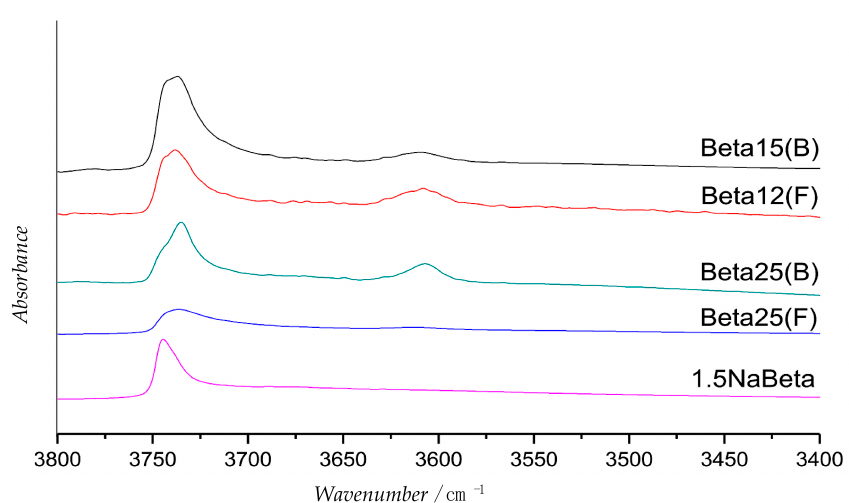
Figure 8. IR spectra of Beta-zeolites synthetized in fluoride (F) and OH − media (B). The silanol band at 3745 cm − 1 is less pronounced for Beta-zeolites prepared in a fluoride medium and for Beta-zeolite with higher Si / Al ratio. Adapted from Reference [65].